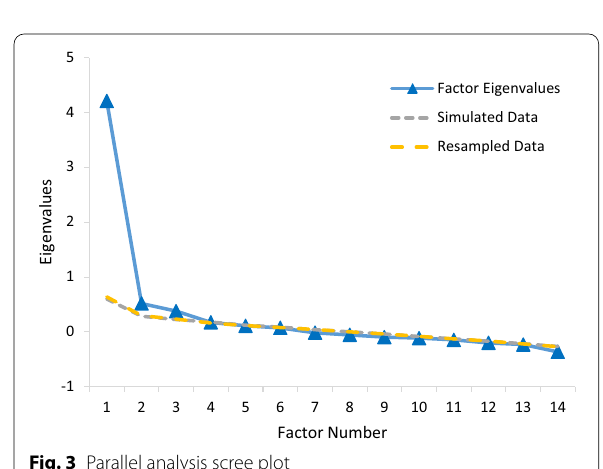
Fig. 3 Parallel analysis scree